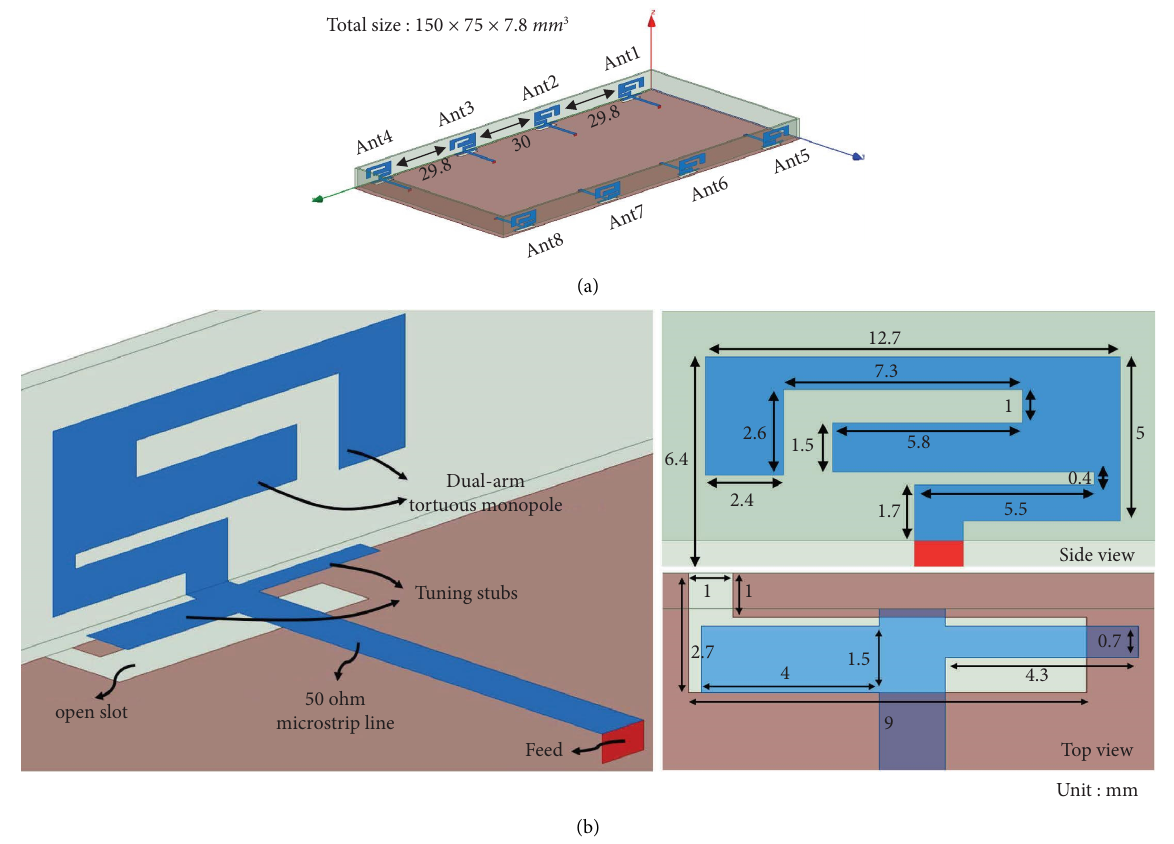
Figure 1: (a) Te confguration of the MIMO antenna array and (b) the detailed parameters of the single antenna